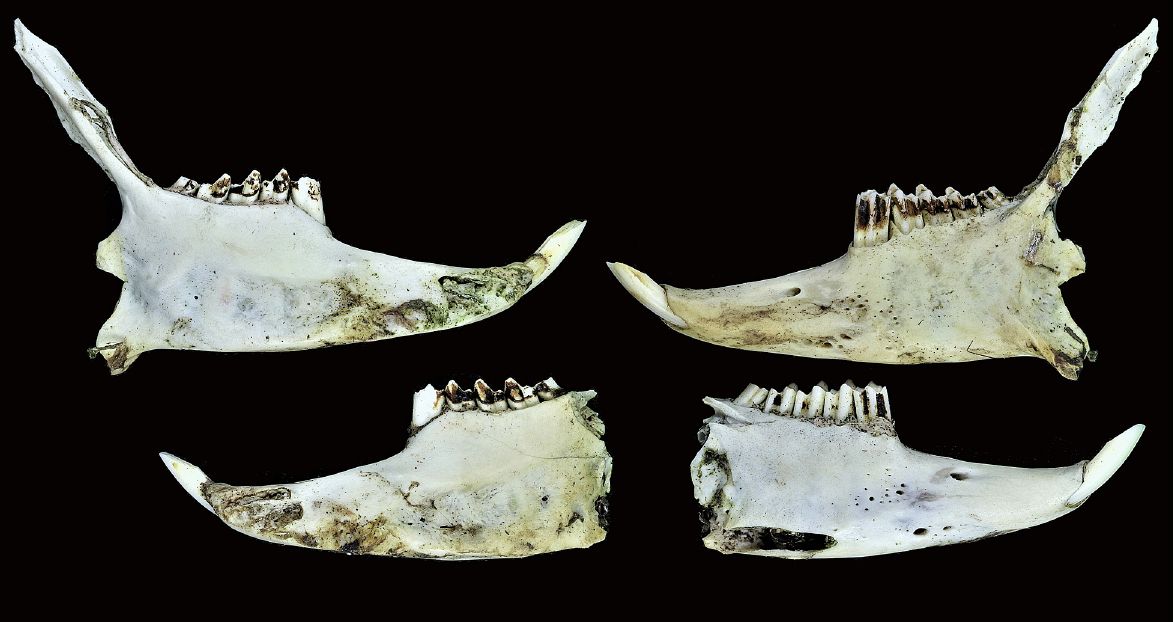
Figure 1. Lower jaw fragments of Lepus timidus (Linnaeus, 1758) from the Novaya Zemlya Archipelago (photo by Vitaly M.